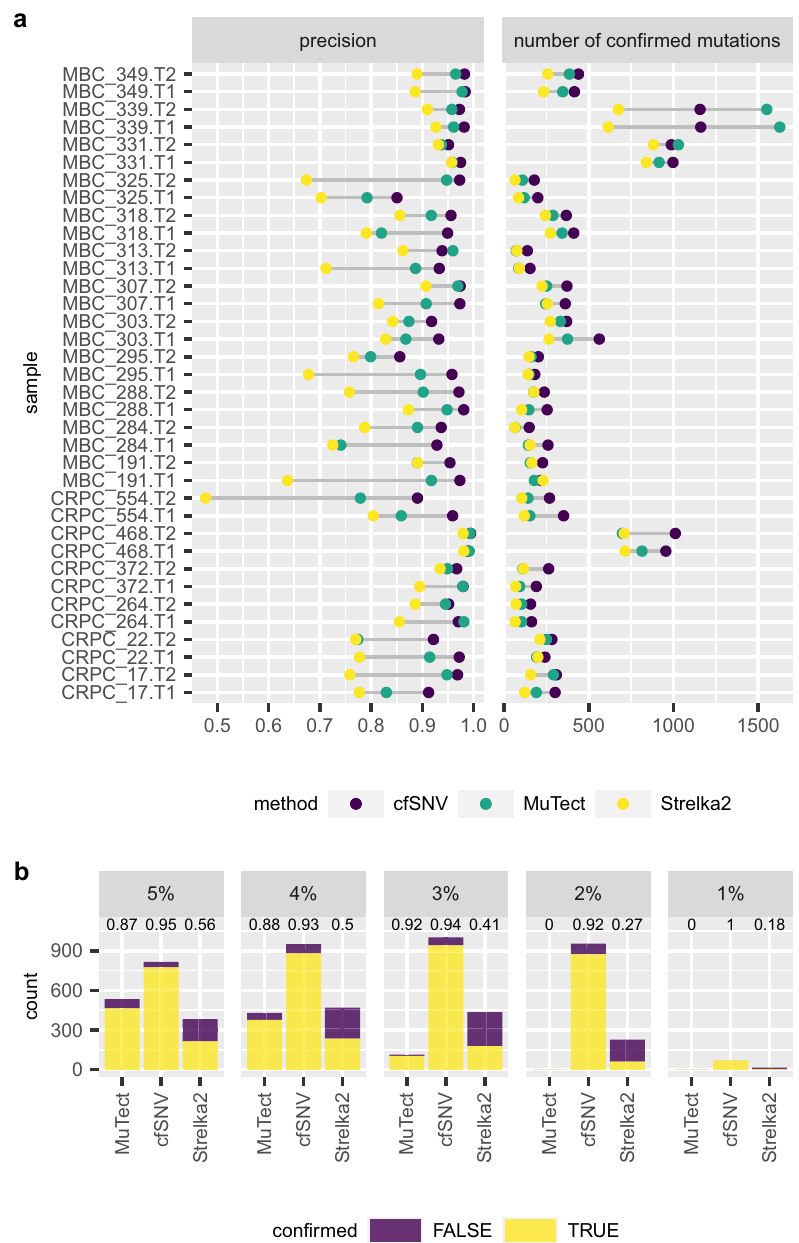
Fig. 3 Somatic SNV calling on cfDNA sequencing samples from cancer patients. a Total number of con fi rmed mutations and precision using cfSNV, MuTect, and Strelka2. The precision is the number of con fi rmed mutations (in either the tumor biopsy or the plasma sample) divided by the total number of detected mutations. In the sample name, T1 and T2 indicate the fi rst time point and the second time point of blood plasma samples respectively. b The total number of low-frequency variants and their con fi rmation status found by cfSNV, MuTect and Strelka2 from all plasma samples. Low-frequency variants are divided into fi ve groups according to their rounded VAF, and the number of con fi rmed and uncon fi rmed mutations for each variant group are plotted in fi ve sub fi gures for comparing between our method and two competing methods. The number at the top of each bar indicates the